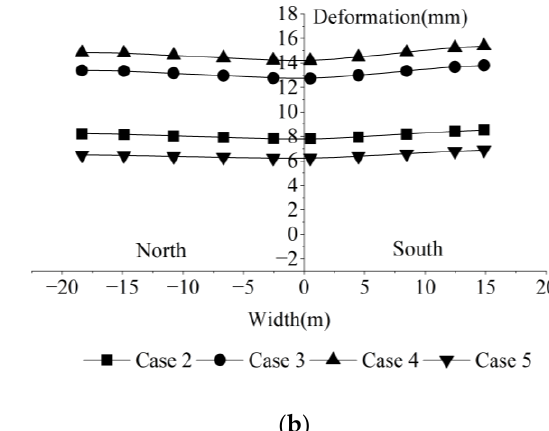
Figure 12. Lateral deformation of supporting pile subjected to symmetric construction: ( a ) southern pile and ( b ) northern pile (unit: mm).